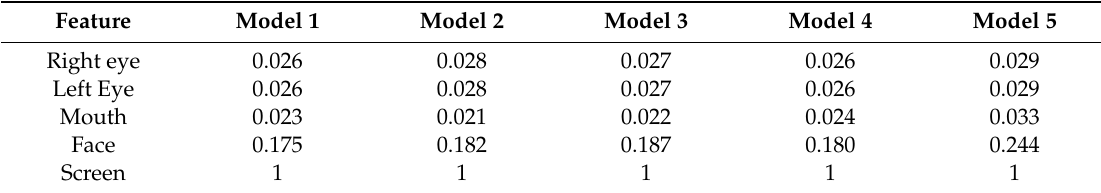
Table A2. Size of interest areas as a proportion of total screen size.